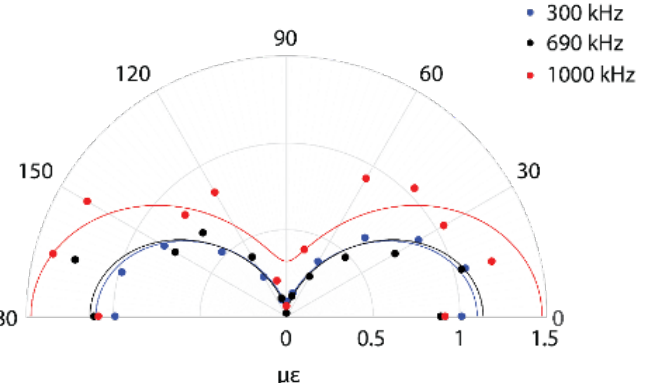
Figure 19. The angular response of directly bonded FBGs to S 0 mode with different excitation frequencies plotted in polar coordinate system.